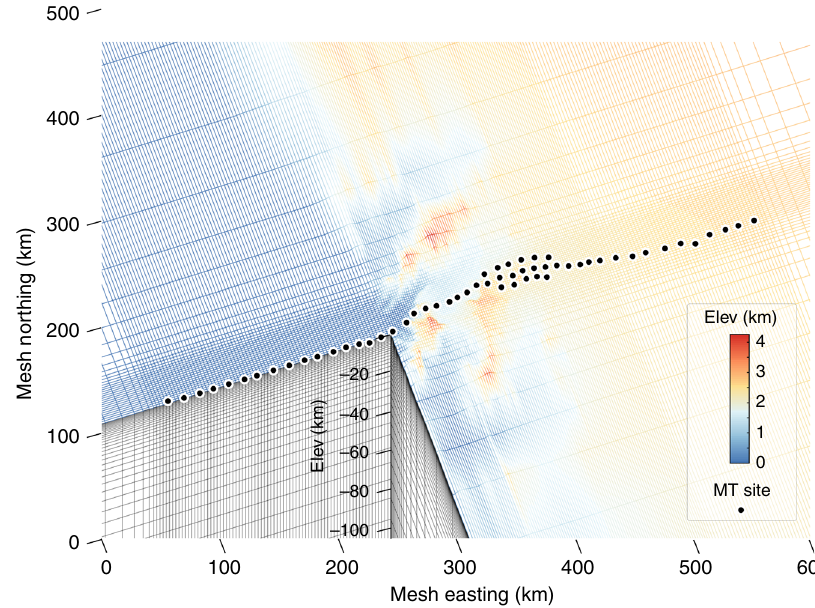
Fig. 5 Central portion of hexahedral fi nite element mesh. This mesh is used to simulate and invert MT data across the central Transantarctic Mountains. Element elevations are indicated by color. Each element is a parameter in the regularized data inversion. The mesh coordinates are local, where (0, 0) corresponds to UPS (2006835.5E,